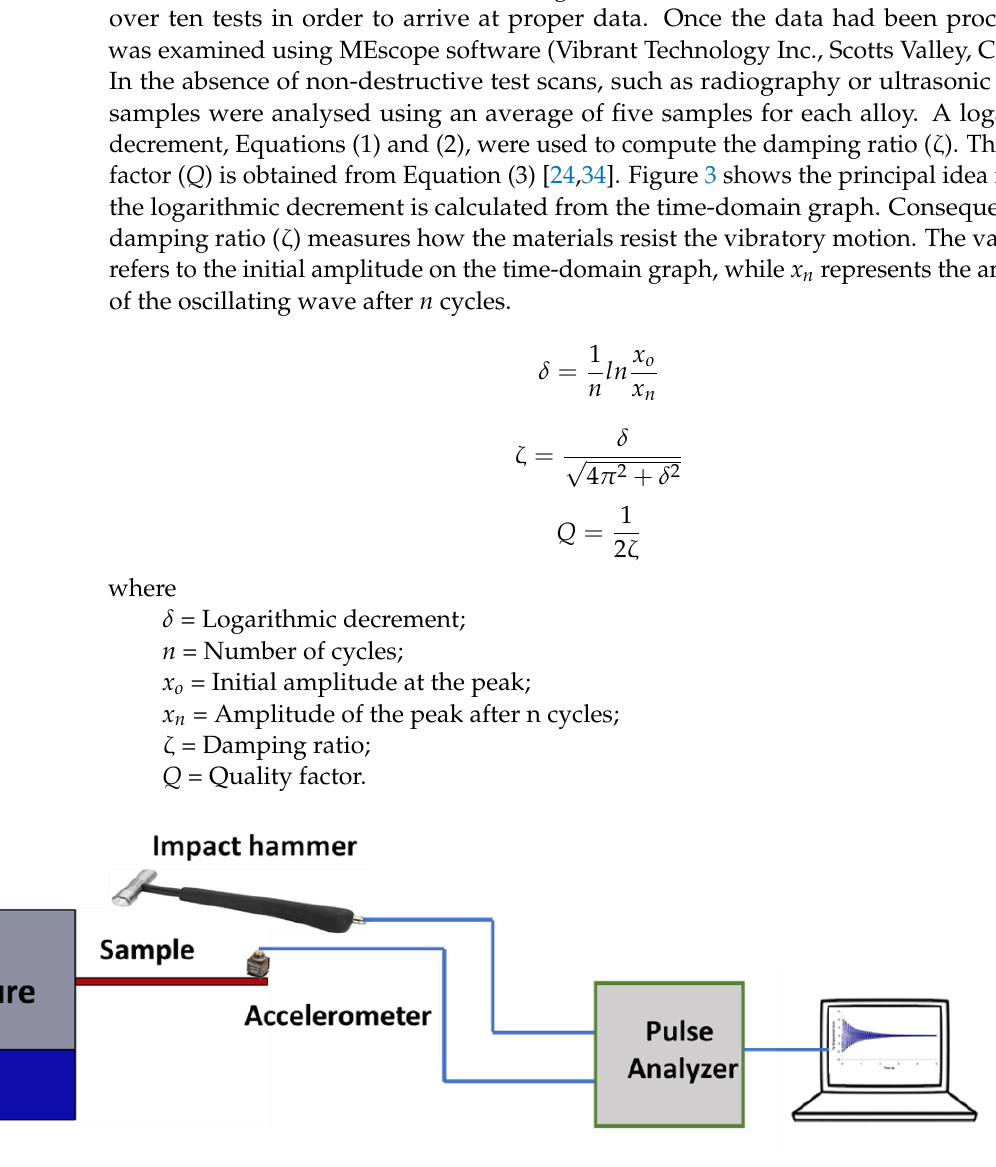
Figure 2. Schematic drawing of the free vibration impact